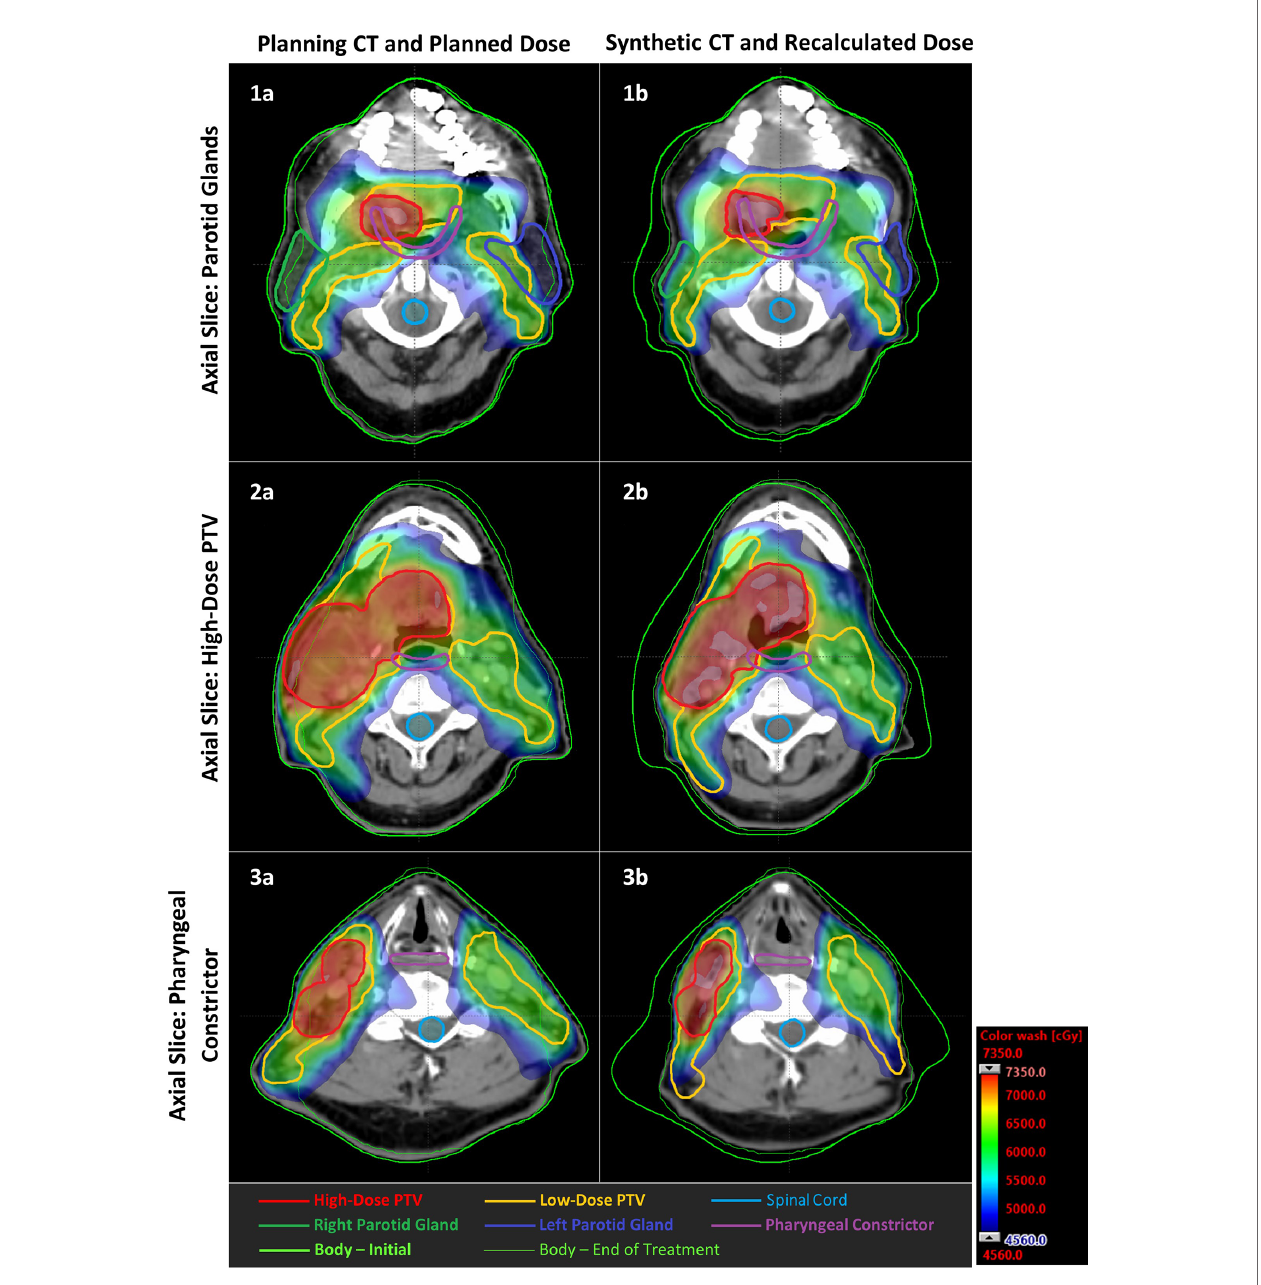
FIGURE 4 | Example of the changes in patient geometry and dosimetry between the planning CT ( A : left column) and synthetic CT ( B : right column), here assessed at fraction 31 of 33. The patient shown was identi fi ed as having changes representative of approximately 12% of the training cohort, according to data clustering performed for deformable image registration quality assurance. Axial slices correspond to: 1) the centers of mass of the parotid glands; 2) centre of mass of the high- dose PTV; 3) centre of mass of the pharyngeal constrictor, assessed for the planning CT and rigid alignment of the synthetic CT. A dose color wash indicates doses ranging from 95% of the maximum allowable spinal cord dose, to 105% of the high-dose prescription. Anatomical structure contours are overlaid. Notably, the patient experienced weight loss, loss of parotid gland volume, and a general increase in doses to healthy